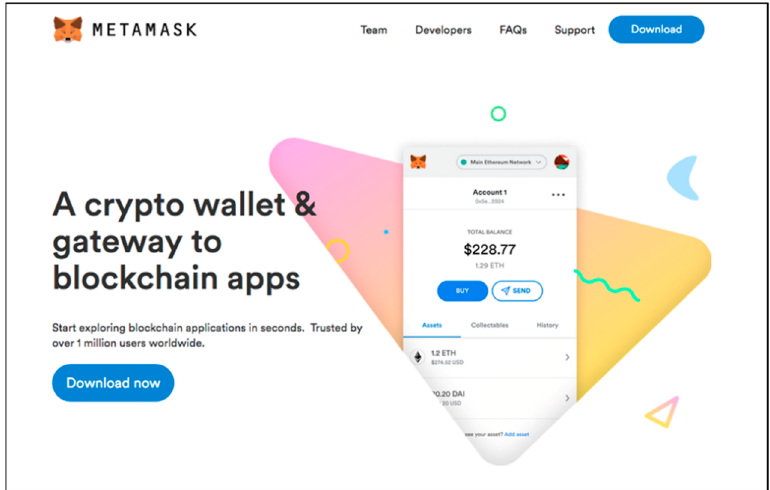
Figure 17. TSO-DSO coordination using Blockchain.